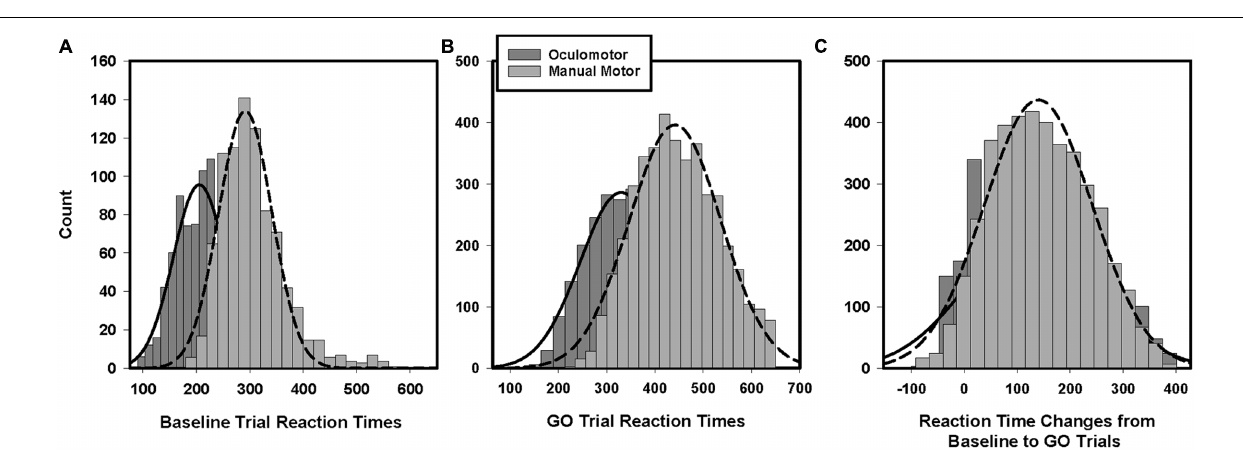
FIGURE 3 | Histograms of baseline and GO trial reaction times. Manual motor reactions times during the baseline trials (A) and GO trials (B) are longer than oculomotor reaction times. Manual motor reaction times also were slowed to a greater degree than oculomotor reaction times from baseline to GO trials (C)